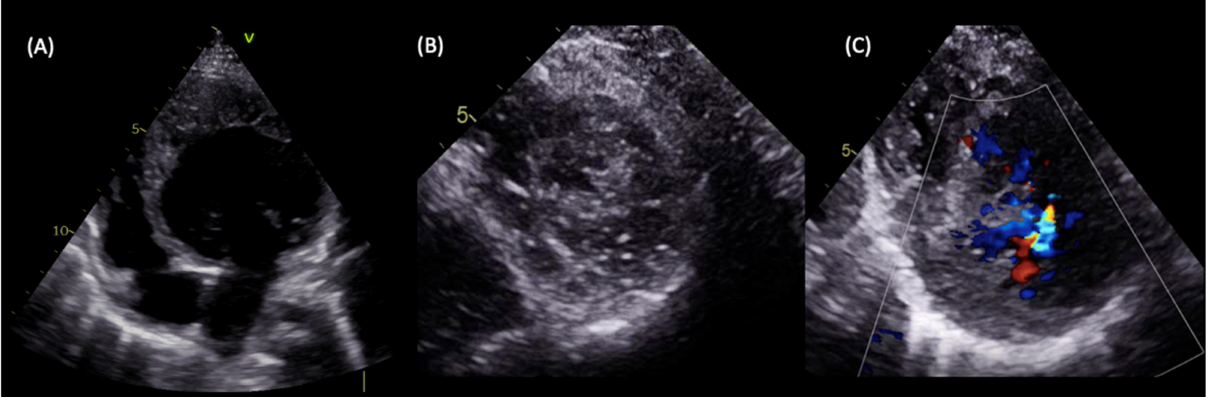
Figure 4. LVNC in a 5-year-old patient with a family history of dilated cardiomyopathy presenting with heart failure symptoms. Transthoracic echocardiography showed dilated LV with severely impaired systolic function and an estimated ejection fraction of 30% ( A ), the spongy aspect of the apex on echocardiographic short axis view ( B ), and perfused intertrabecular recesses seen on a Colour Doppler ( C ), which are compatible with LVNC diagnosis according to both the Jenni and Stöllberger